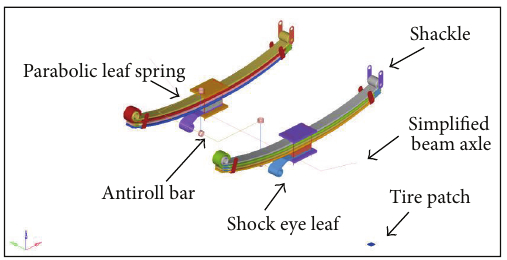
Figure 3: Roll load case simulation